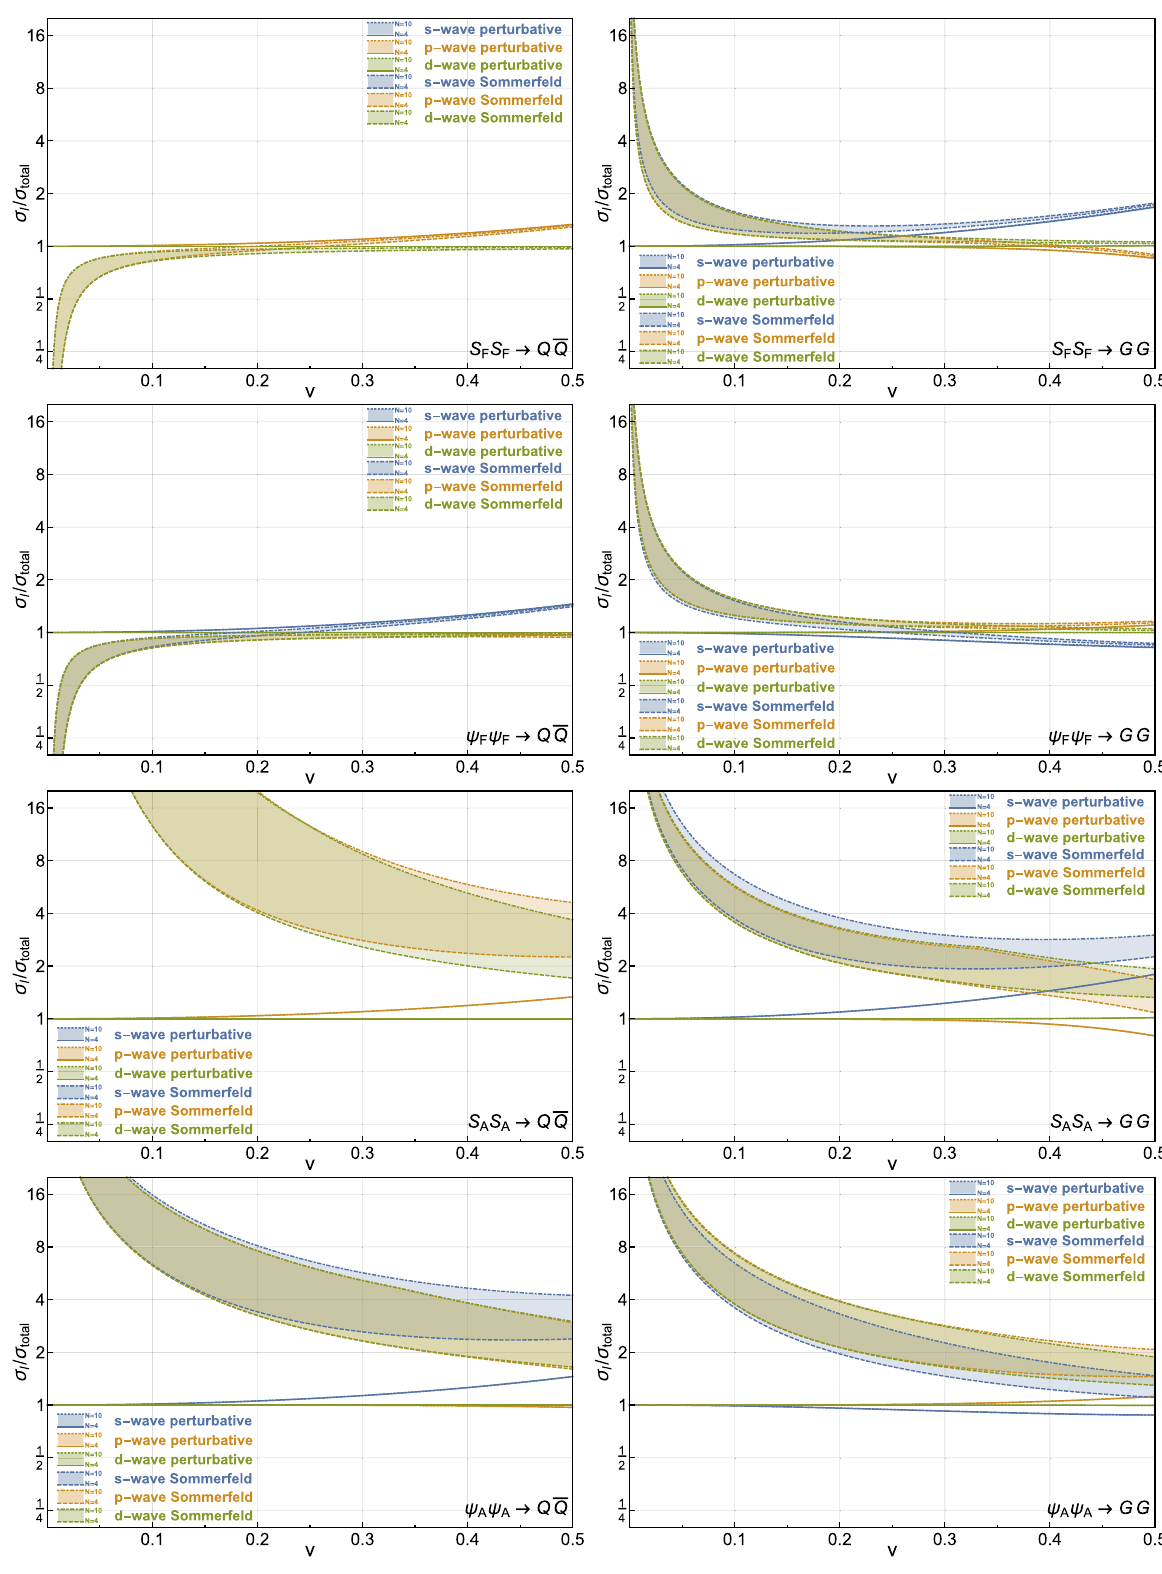
Fig. 4 Ratios of the perturbative ( solid lines ) and Sommerfeld- correctedcrosssections( dashedlines )expandeduptothe s -wave( blue ), p -wave ( orange ) and d -wave ( green ) over the total perturbative cross